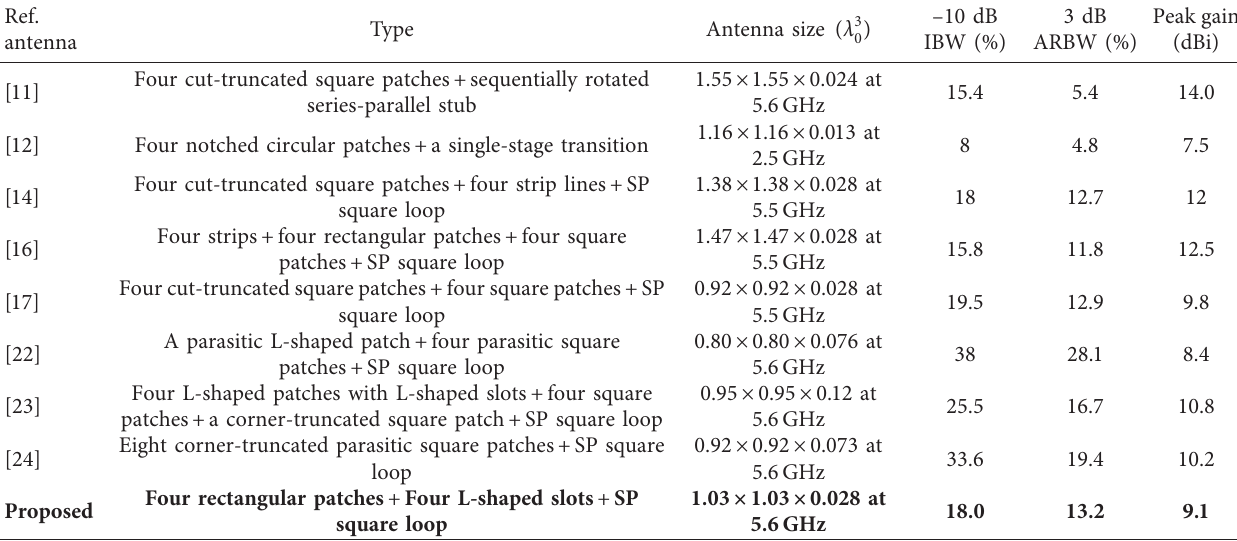
Figure 2: Four antenna structures in the design process and corresponding | S (b) AR curves, and (c) four antenna structures. Table 1: Comparison of the designed antenna with previously reported antennas.